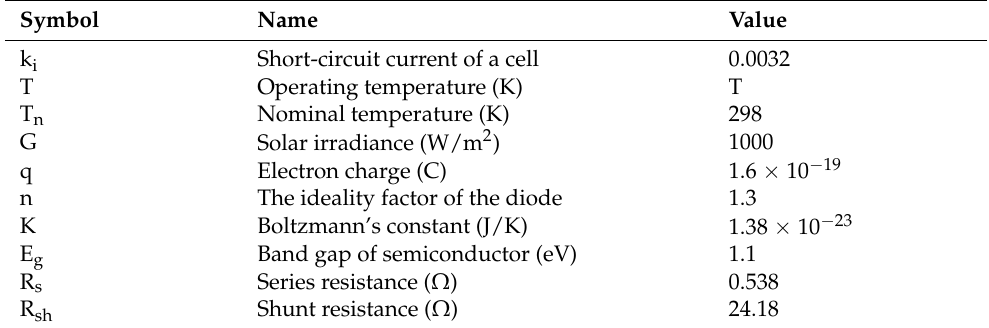
Table 2. Details of mathematical symbols.